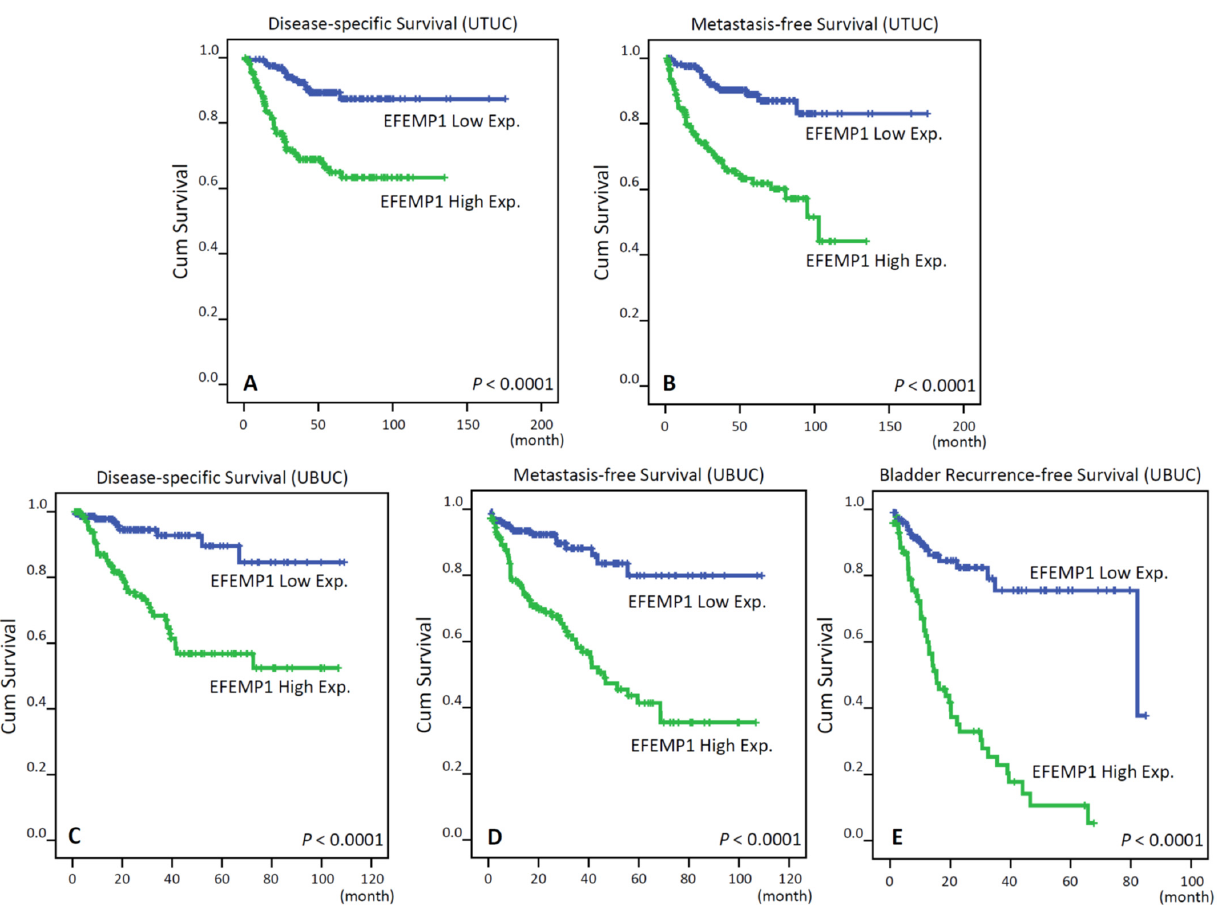
Figure 3. Kaplan-Meier plots show that EFEMP1 overexpression confers significant prognostic impacts in disease-specific survival, metastasis-free survival and bladder recurrence-free survival of patients with urothelial carcinoma of the upper tract (UTUC) ( A , B , respectively) and urinary bladder (UBUC) ( C – E respectively). In UBUC (Table 4), 43 patients (29.1%) with high EFEMP1-expressing tumors expe-